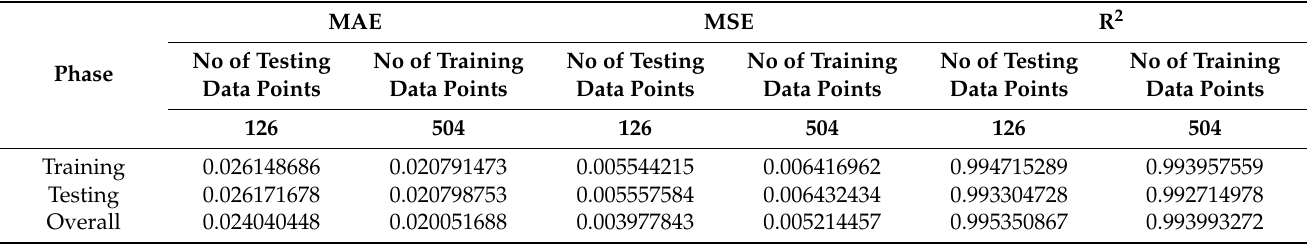
Figure 14. Comparison of original (blue) and predicted (orange) at ( a ) 47.5° E, 20.5° N; ( b ) 50.5° E, 22.5° N